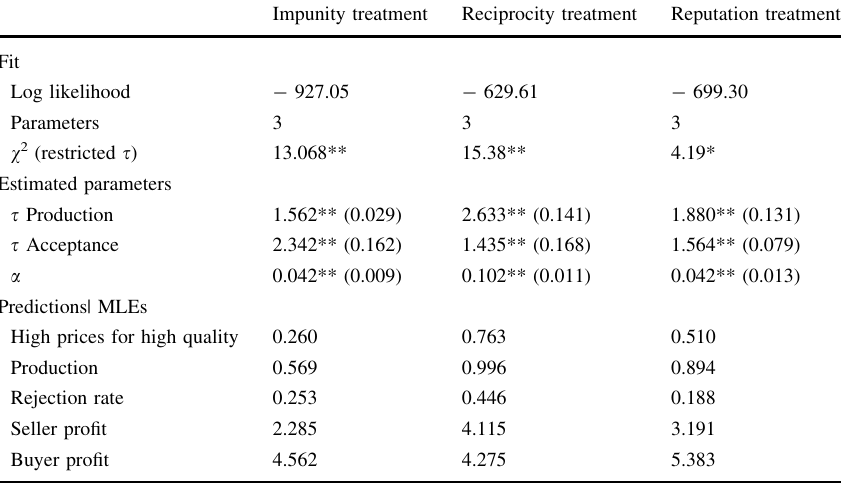
Table 2 Estimation results and predictions based on